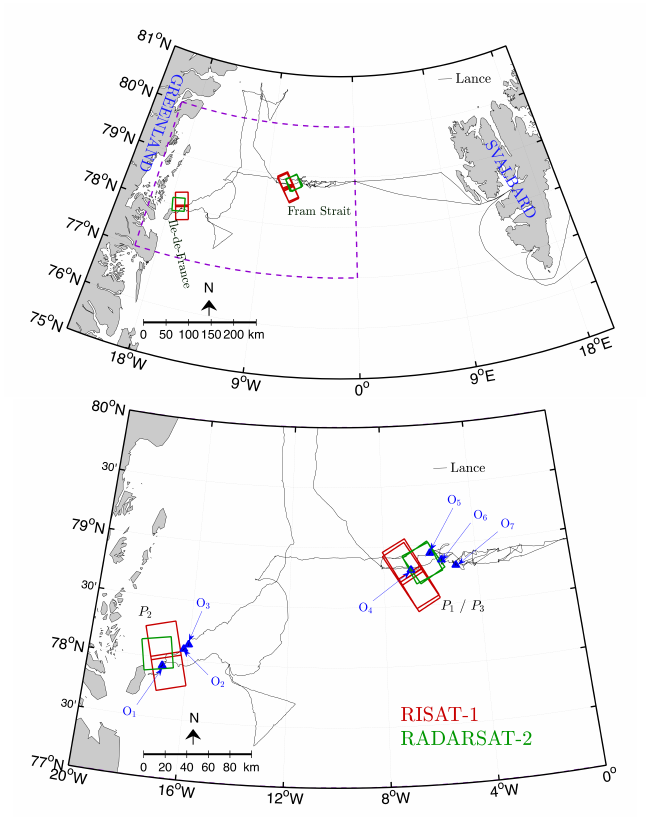
Figure 1. The top map shows the location of the scenes, R/V Lance’s track positions (black lines), and the dashed purple square outlines the zoomed-in map on the bottom. The zoomed-in map shows marked areas on R/V Lance’s track positions where relevant in-situ sea ice observations for this study were obtained. The zoomed-in version (the bottom map) is the dashed purple square in the larger map. The zoomed-in version contains seven marked positions (indicated by an O symbol) and these